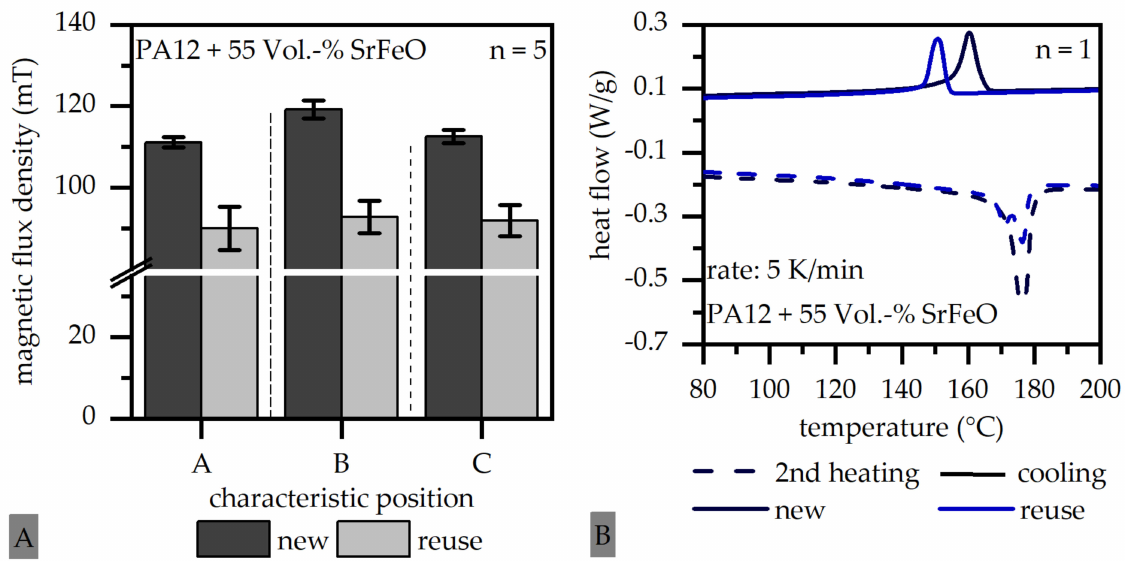
Figure 13. Change of the magnetic flux density due to reuse of shreds ( A ) and DSC measurement ( B ) based on thermoplastic compound PA12 with 55 vol.-%